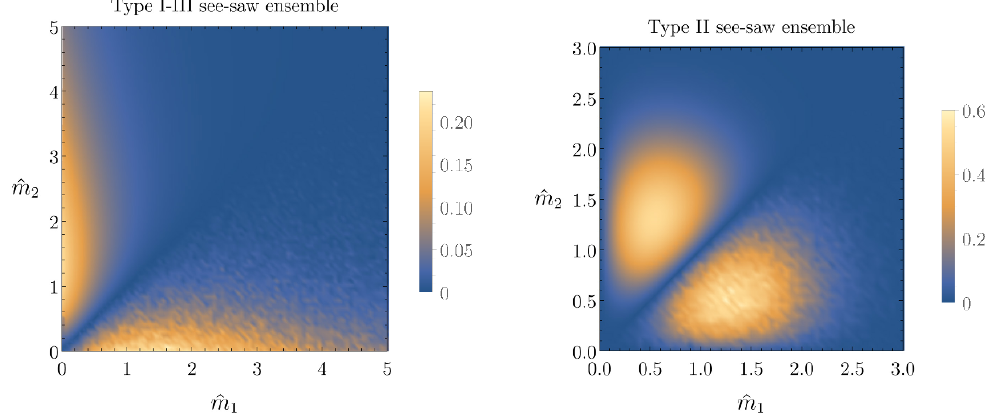
Figure 3 . Density plots of the singular value pdfs for the complex seesaw ensembles with N = 2. The left and right panels show the density plots of the type I-III [ P I-III [ P II ( ^ m 1 ; ^ m 2 )] seesaw ensembles respectively. The plots are split along the symmetry axis so that (cid:23) the upper and lower triangles show the analytical and numerical results (with 10 5 dimensionless light neutrino mass matrices generated) respectively. There is no ordering of the singular